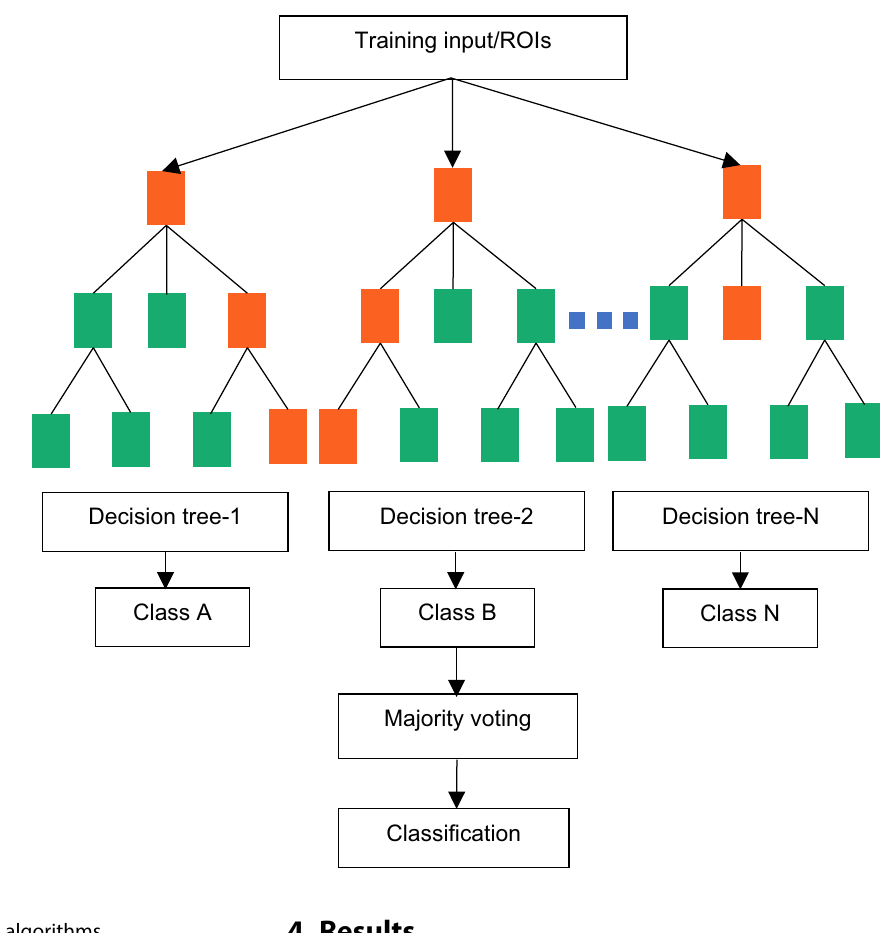
Fig. 6 Implementation of generalized RF decision tree models on the training data sets (ROIs)